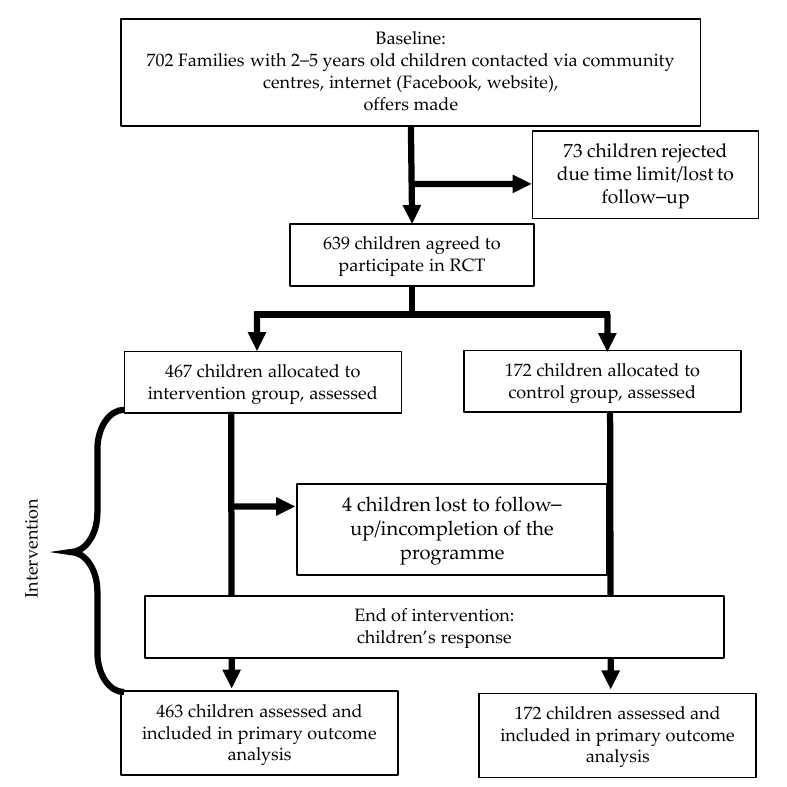
Figure 2. Timeline flow